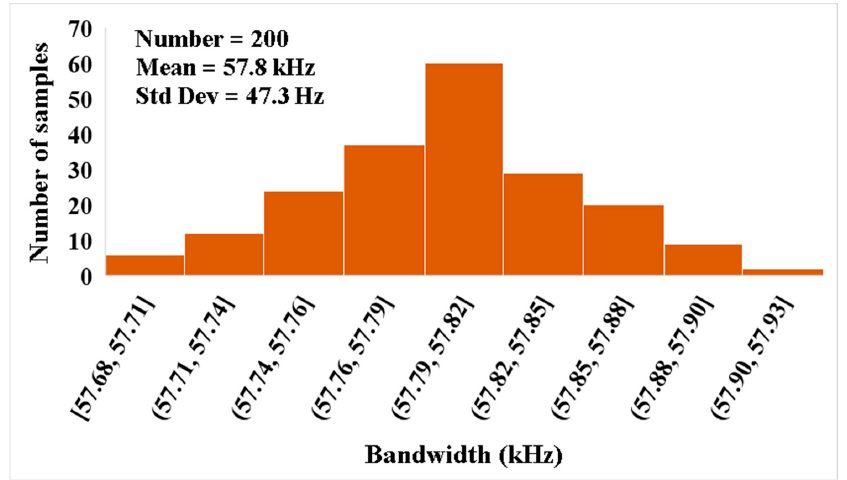
Figure 14. The histogram of the bandwidth of the BP filter with 200 runs of the Monte Carlo analysis. The results of the process, voltage and temperature (PVT) corner analysis of the BP filter are shown in Figure 15. The process corners for the MOST were fast-fast, fast-slow, slow-fast and slow-slow, for capacitor and resistor corners were fast and slow, the voltage supply corners VDD = − VSS were 890 mV and 910 mV and, finally, the temperature corners were − 20 and 80 ◦ C. While the nominal value of the BW is 57.8 kHz, the minimum BW is 57.17 kHz, and the maximum BW is 58.55 kHz under all corner variations. To test the third intermodulation distortion of the BP filter, two closely spaced tones were applied to the input of the BP filter. The first tone was a sine wave signal with 100-mVpp @ 49 kHz and the second tone with 100-mVpp @ 51 kHz. The spectrum of the output signal is shown in Figure 16. The third intermodulation distortion (IMD3) was − 65.148 dB. Figure 17 shows the IMD3 of the BP filter versus the peak-to-peak value of the input signal. It is clear that the filter offers IMD3 of − 34 dB for the 600-mVpp input signal. As shown in Figure 18, the RMS value of the output noise integrated in the pass band of the filter (29.11 kHz–86.9 kHz) is 46 µVrms, and the RMS value of the input signal for 2% IMD3 is 0.2121 V; hence, the dynamic range of the BP filter is 73.27 dB.